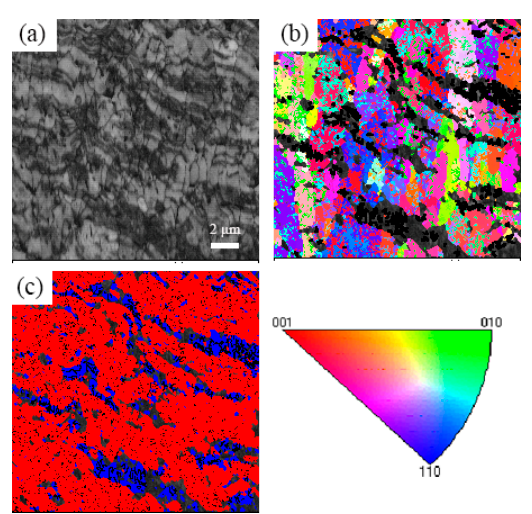
Figure 5. EBSD images of TBC YSZ-1: ( a ) quality maps; ( b ) orientation maps; ( c ) phase maps; The orientations are defined by tetragonal lattice symmetry.